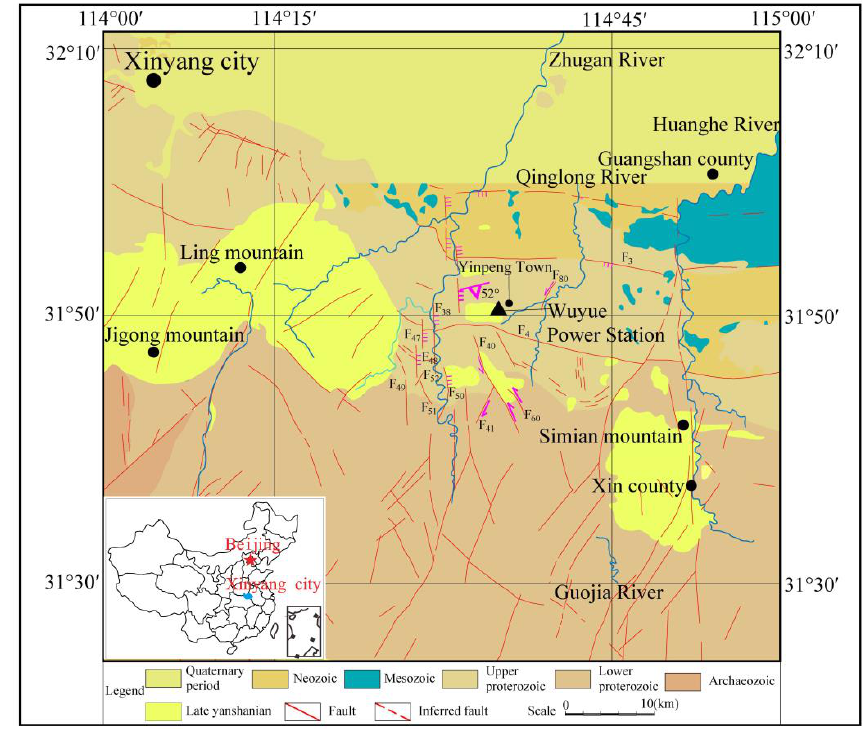
Figure 1. Regional geological structure of the area close to the Wuyue power station.